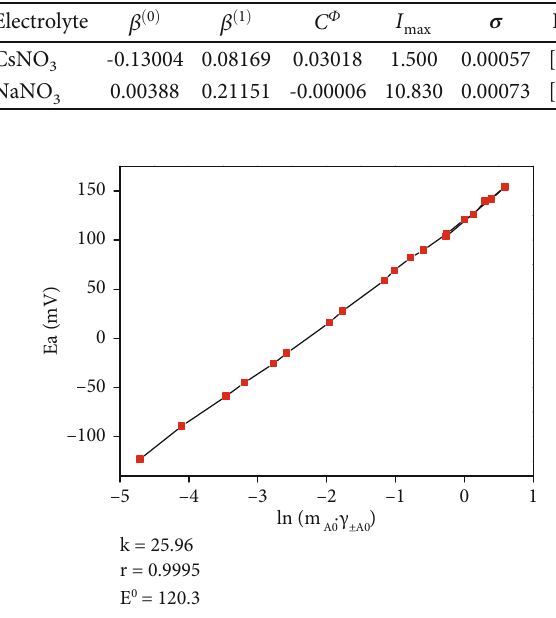
-ISE electrode pair. 3 solutions at di ff erent 3